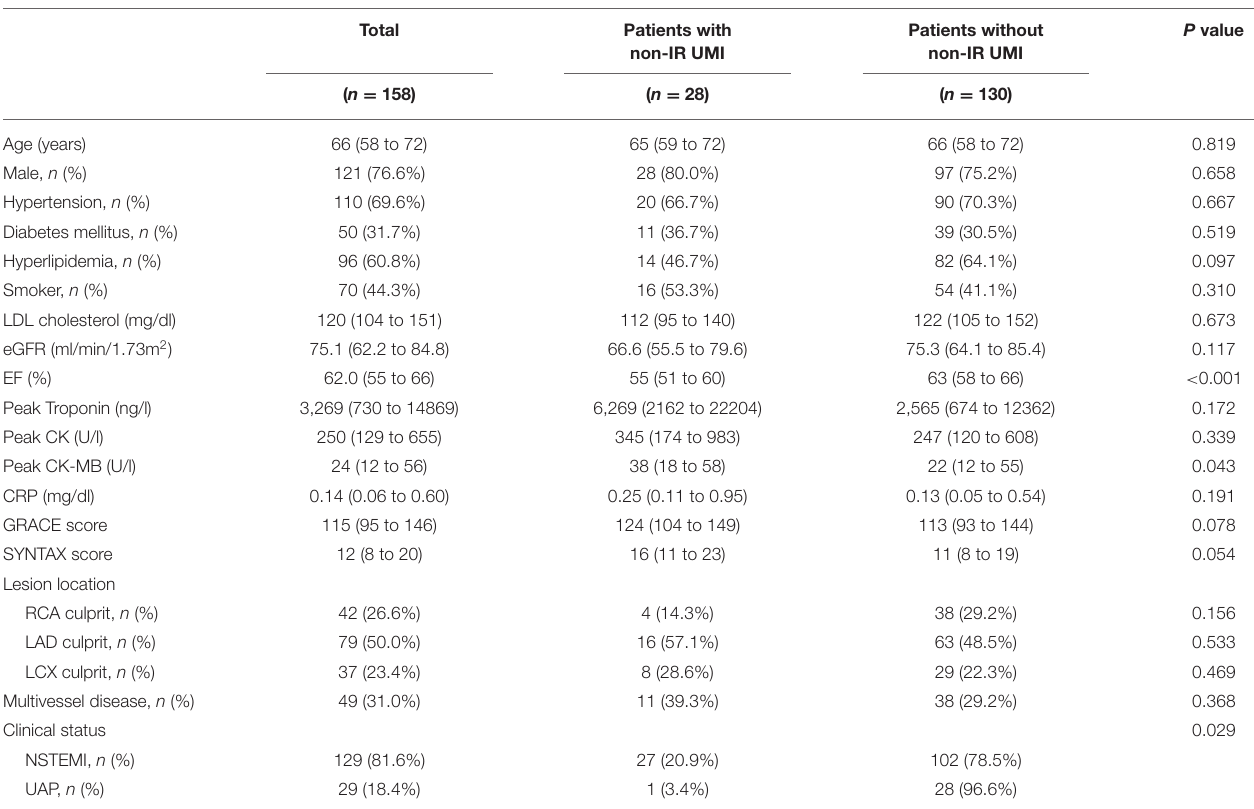
TABLE 1 | Baseline